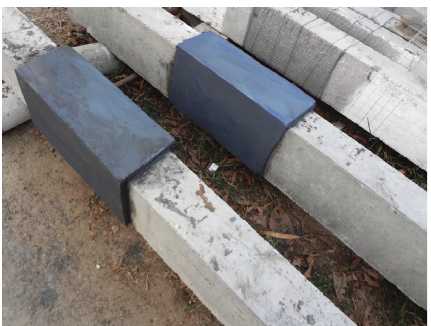
Plate 1: Application of PMF jacketing on the soffit and side faces of the beams (by turning the beams upside